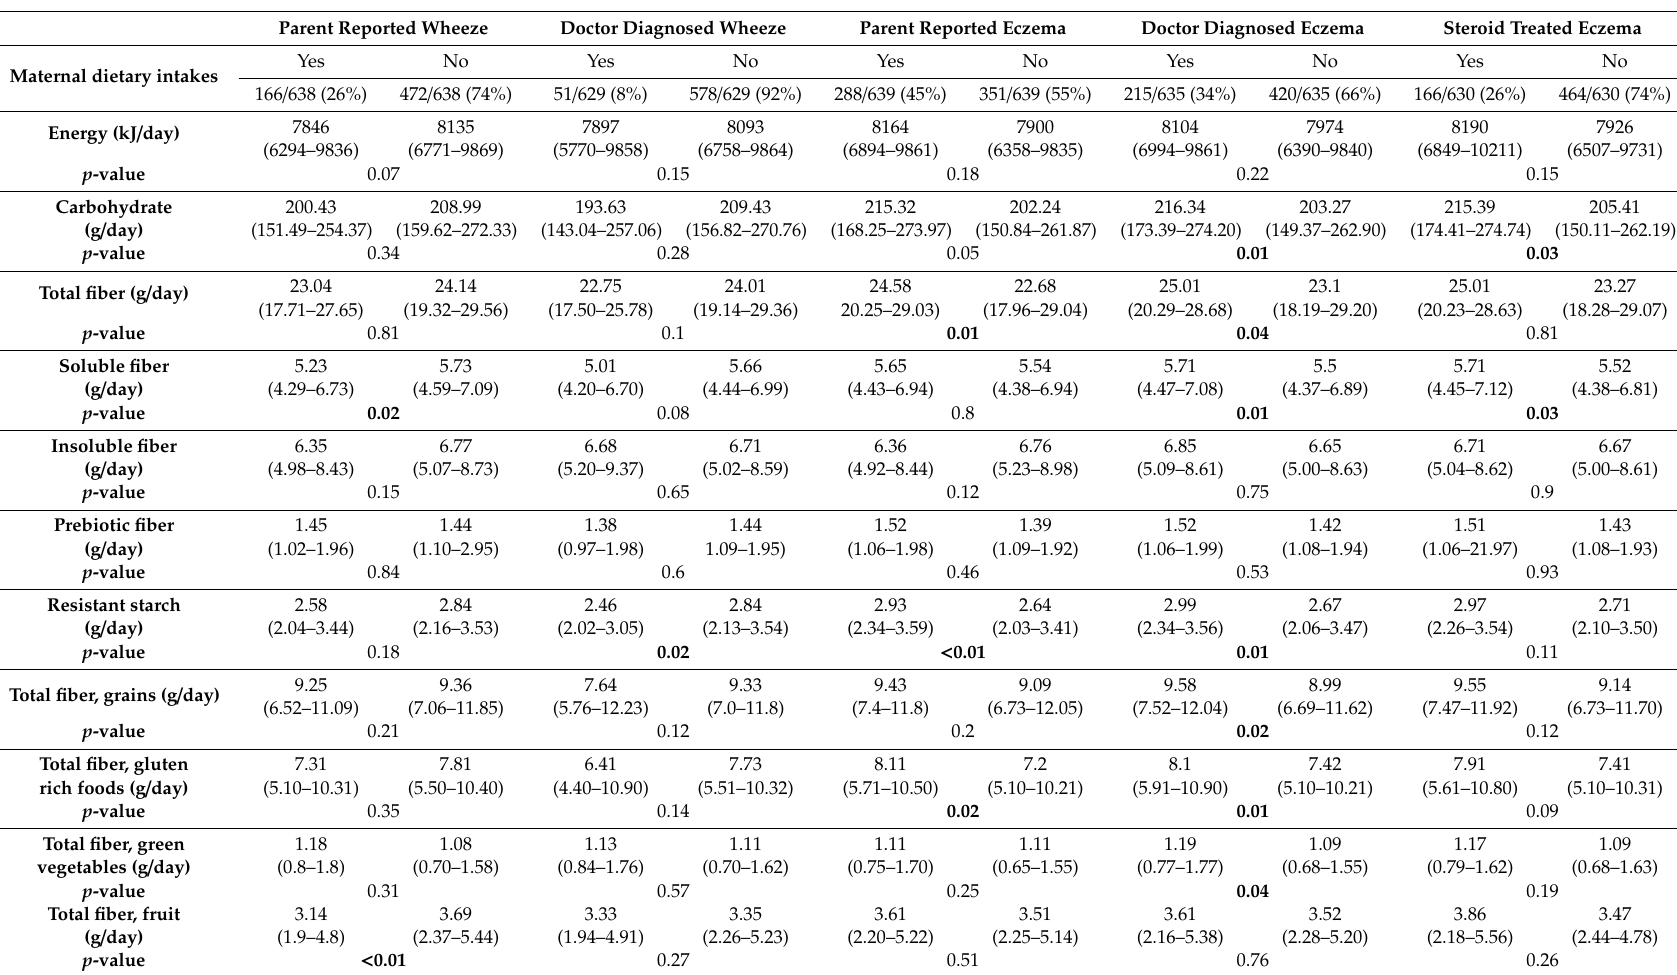
Table 3. Maternal dietary intakes (median and interquartile ranges (IQR)) during late pregnancy and infant wheeze and eczema